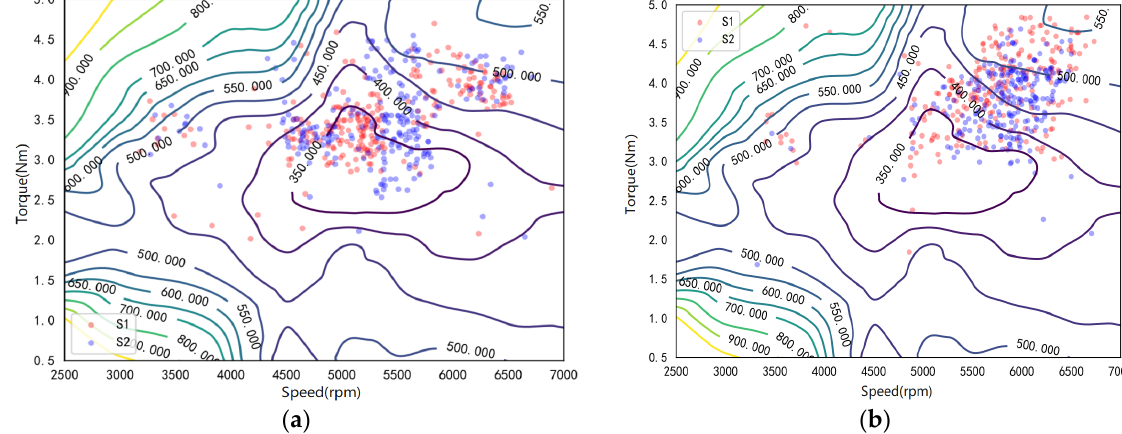
Figure 13. Test trajectories of learning effect: ( a ) short time trajectories; ( b ) long time trajectories.